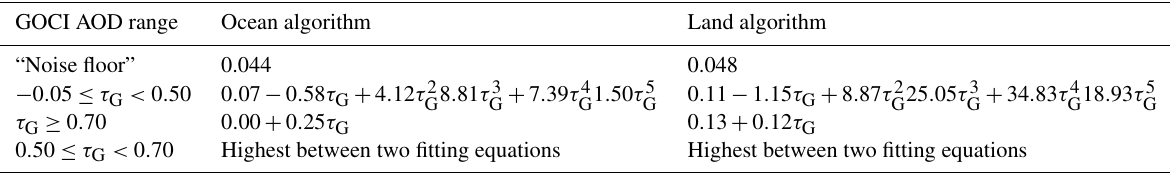
Figure 9. Absolute difference between GOCI YAER V2 AOD and AERONET AOD in terms of (a) AERONET ocean AOD, (b) AERONET land AOD, (c) GOCI YAER V2 ocean AOD, and (d) GOCI YAER V2 land AOD. The diamond, triangle, and square symbols represent the 38th, 68th, and 95th percentiles of 200 collocated data points sorted in ascending order of x axis value. In (a–d) , the red line in each panel is the linear least-squares fit of the 68th percentiles, and the blue and green lines are half and double the red line values, respectively. Table 4. Prognostic expected error (PEE) estimation of GOCI YAER V2 AOD according to the AOD range. The minimum PEE is labeled “noise